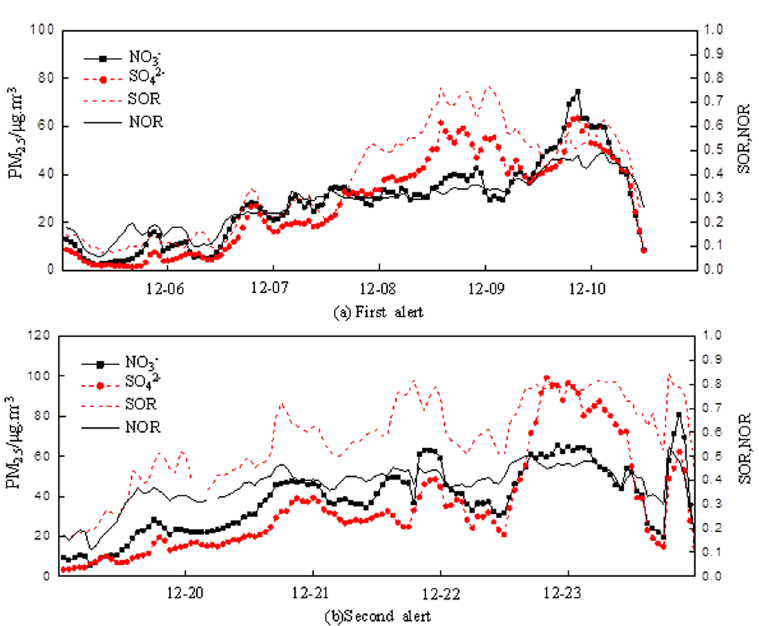
Figure 4. Variations of SO 42 − , NO 3 − , SOR, NOR during two red alerts periods at JCZX site in Beijing in